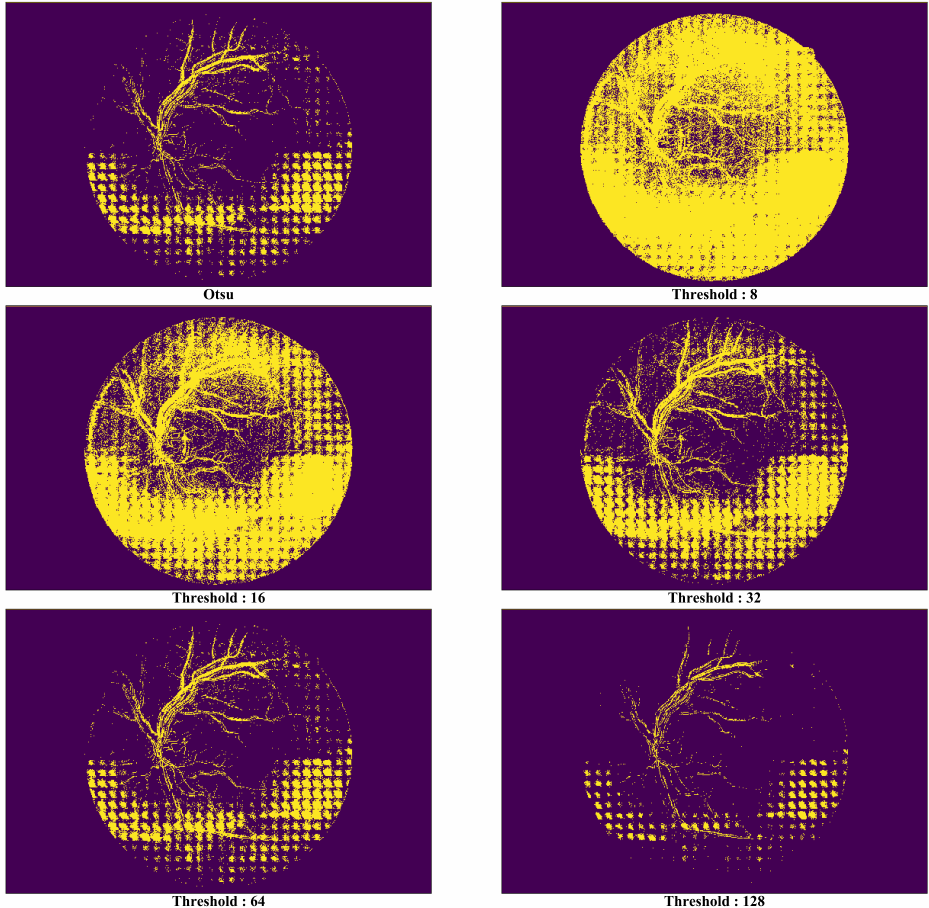
Figure 13. Comparison of synthetic vessel images by threshold